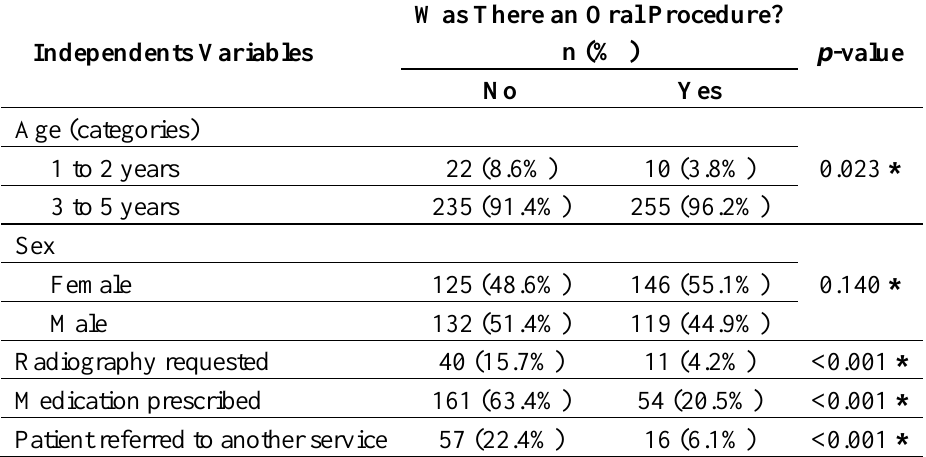
Table 2. Analysis of the relationship between the independent variables and ―performance of oral procedures‖.